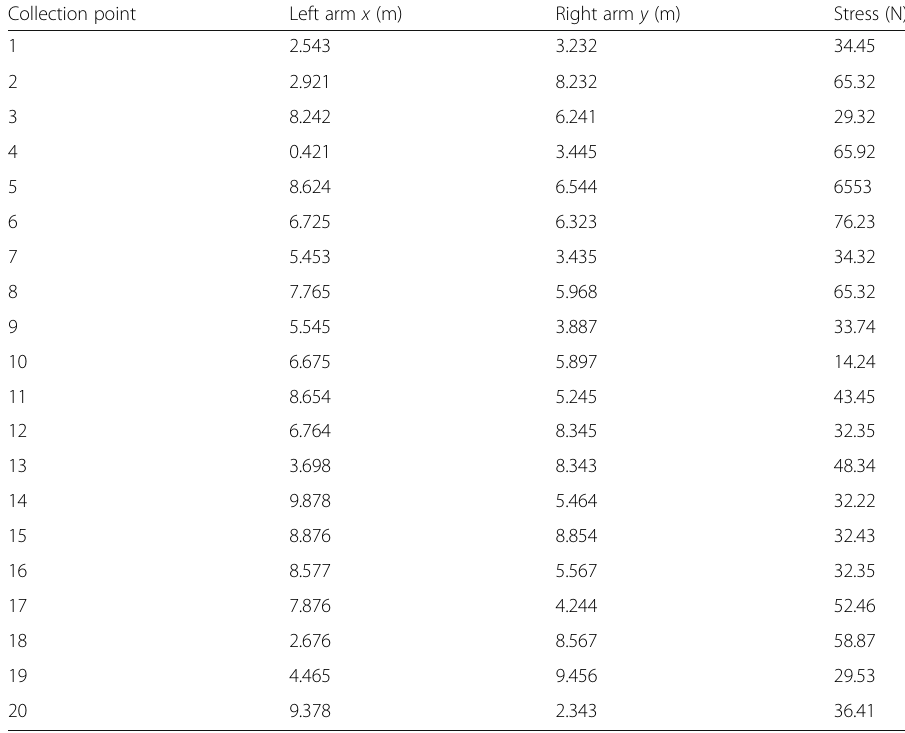
Table 1 Description of simulation results of swimming mechanics parameters